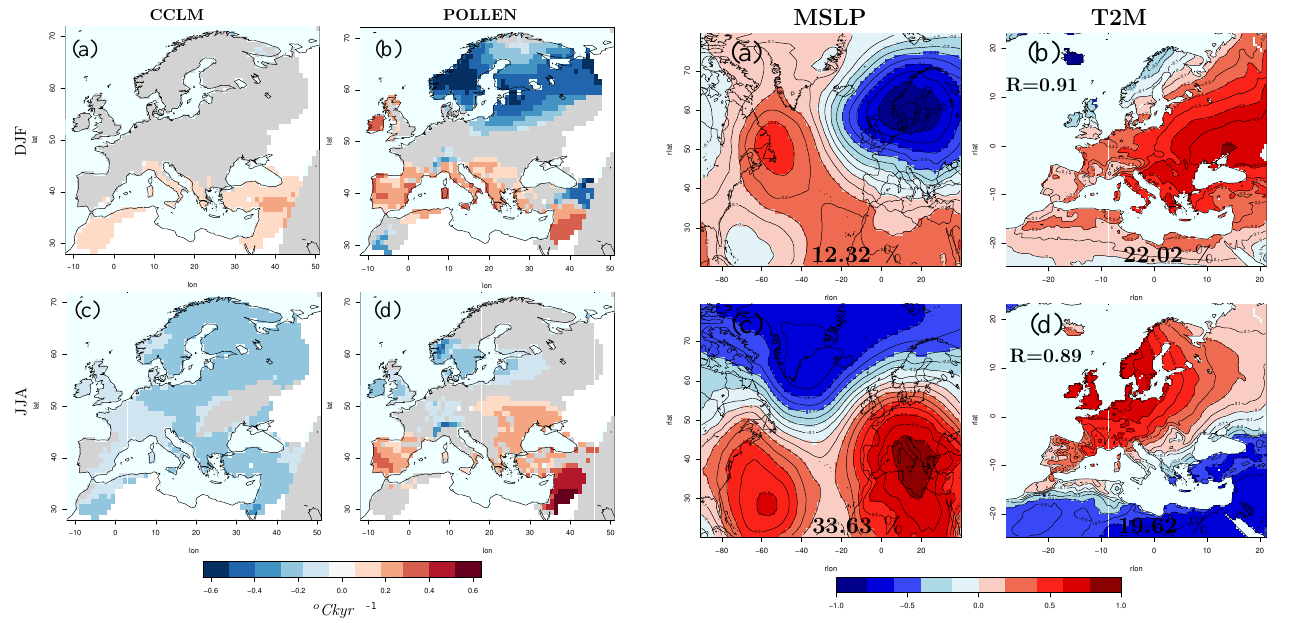
Figure 9. Mid-to-late Holocene temporal Evolution of the anoma- lies, with respect to the pre-industrial period, of near-surface tem- perature winter (first row) and summer (second row) seasonal means, derived from the CCLM simulations (left) and the pollen- based reconstruction (right). The maps show the slopes of the linear trends calculated, for every grid box, taking into consideration the uncertainties associated to the two data sets, by means of a weighted least squares method. The area masked out in grey, are the area where the trends are not significant, according to a F-test at a sig- nificance level of 10%.